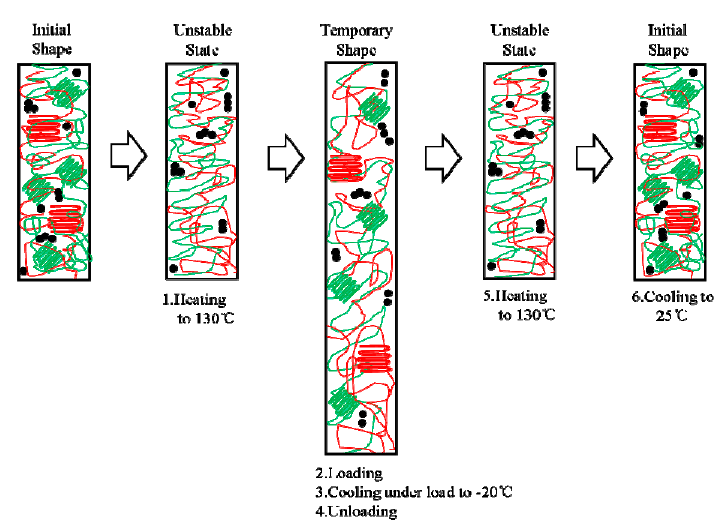
Figure 3. Schematic diagram of shape memory effect for TPI/LDPE/CB composites.